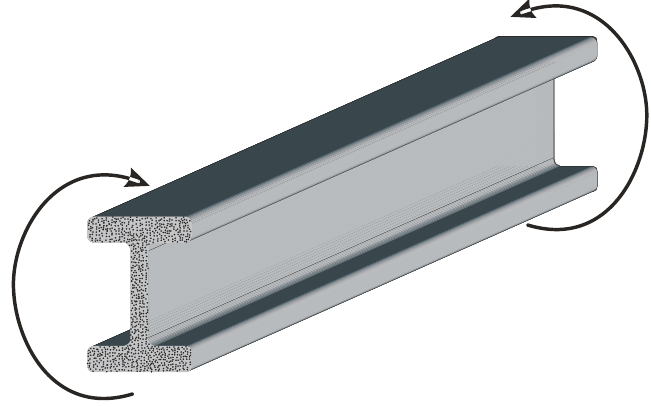
Figure 1 . Torsion of composite bar with simply connected cross